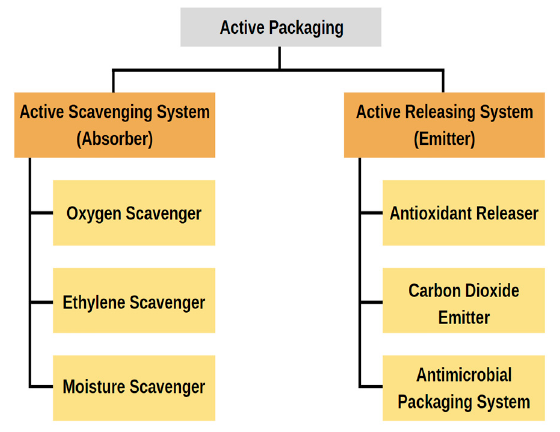
Figure 7. Types of active packaging and its categories.